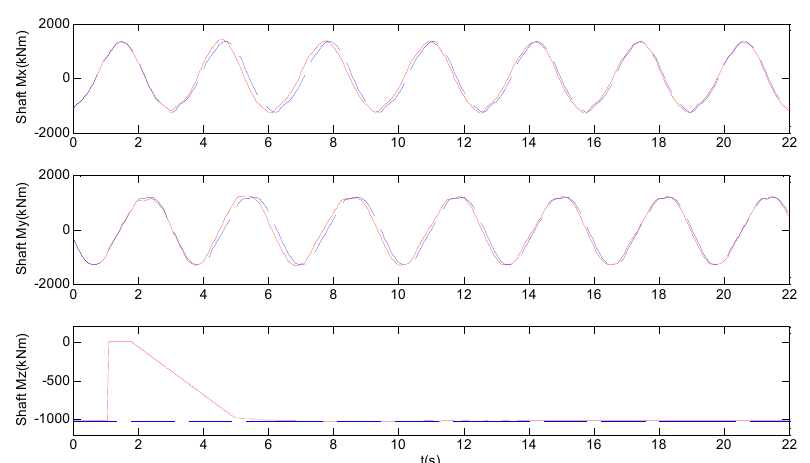
Figure 13. Shaft bending